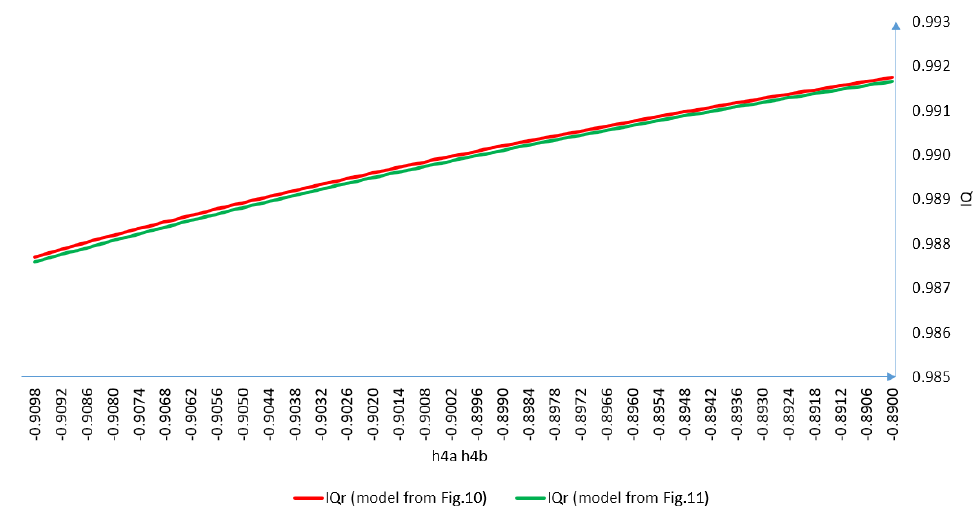
Figure 13. Result of simulating the impact of observation coefficient values for models from Figures